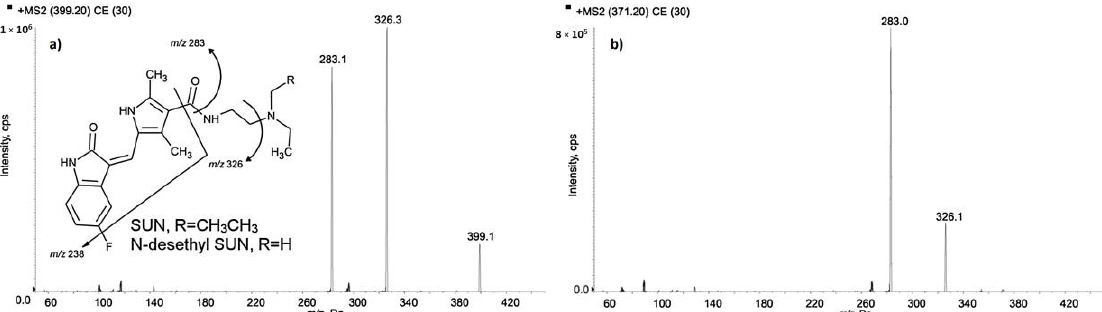
Figure 4. MS/MS mass spectra of sunitinib (SUN) ( a ) and N -desethyl SUN ( b ) with chemical structures and identification of the main fragment ions (CE = 30 V); the 238 m/z fragment was obtained with CE = 60 V for both the analytes [40].